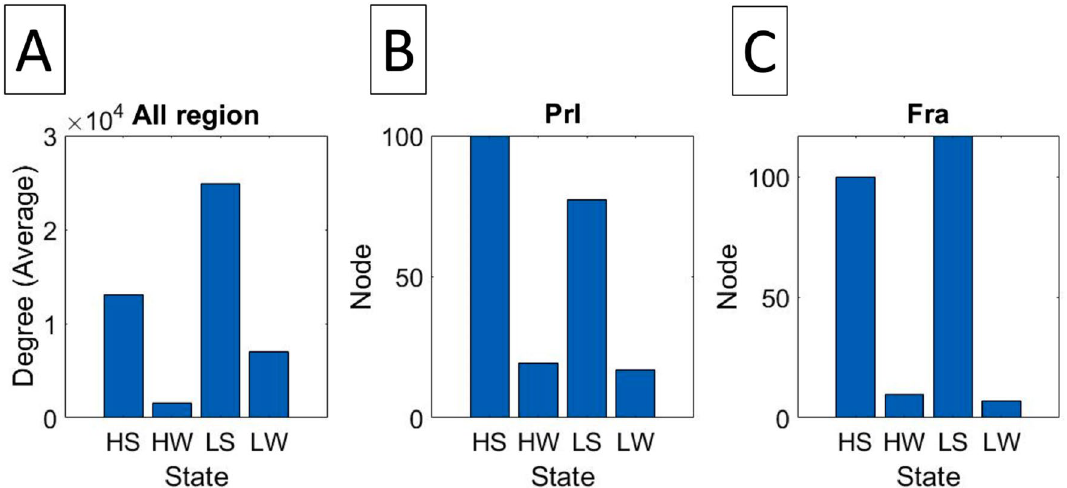
Figure 7. Plot ( A ) shows the total count of degree for the whole brain. Each state consists of 20 samples. ( B ) and ( C ) show Prl and Fra regions where the difference between SHR and WKY is significant. SHR has more nodes than WKY. Each state has 6